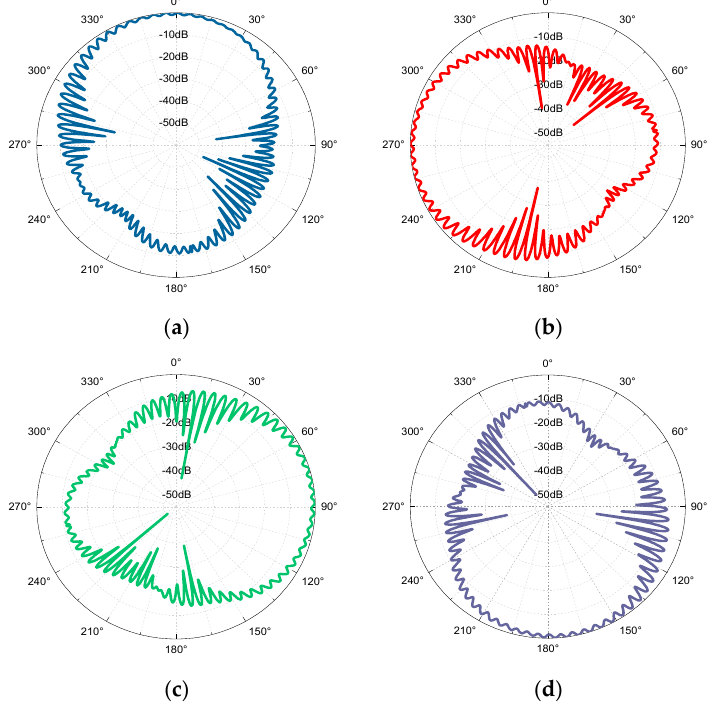
Figure 5. Measured radiation patterns of four states in the azimuth plane. ( a ) Radiation at 0 ° . ( b ) Radiation at 270 ° . ( c ) Radiation at 90 ° . ( d ) Radiation at 180 ° .